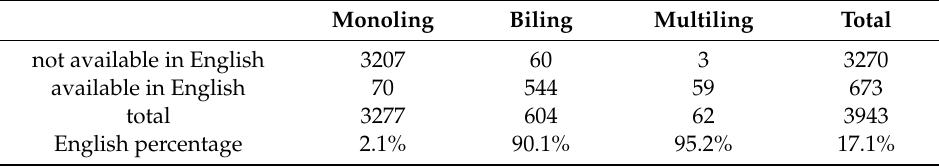
Figure A24. Visualization of the results for domain sk. ( a ) Primary languages pie chart and ( b ) English language availability bar chart. B.25. Slovenia Below, you may find the results for the websites in the TLD .si (Slovenia) (Table A49, Table A50, and Figure A25). Table A49. Primary languages (si). Languages